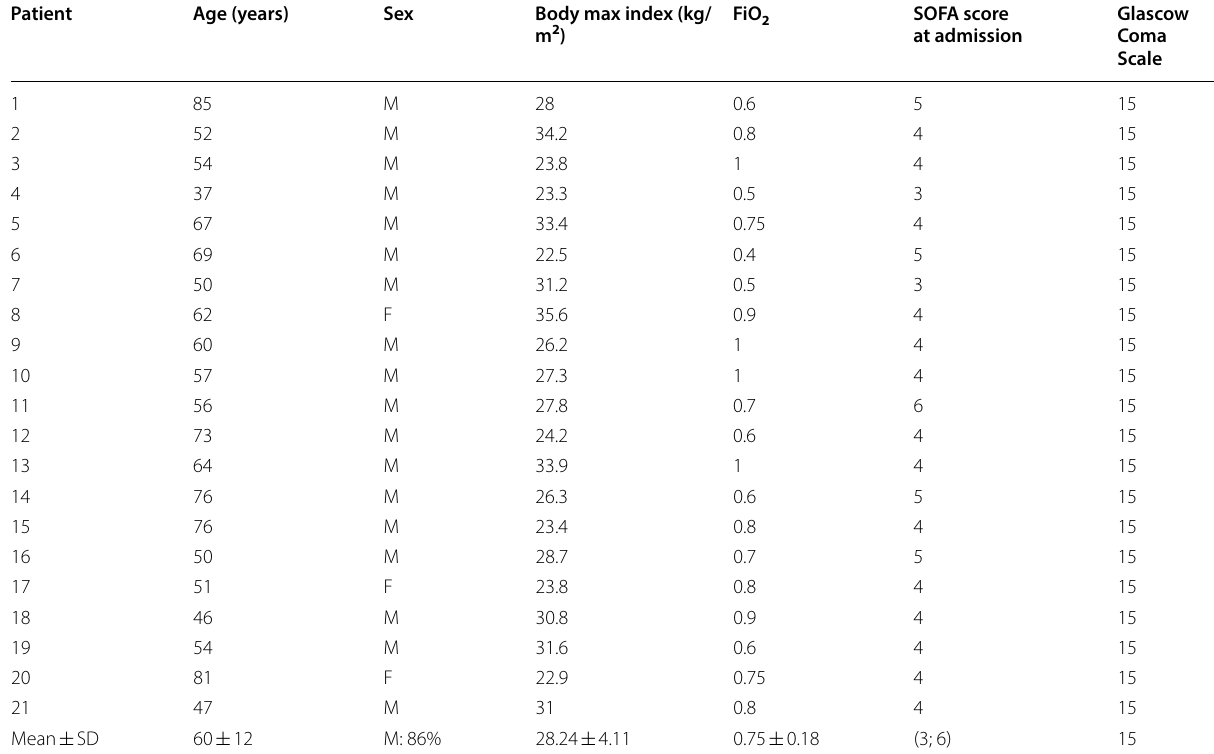
SOFA Sequential organ failure assessment